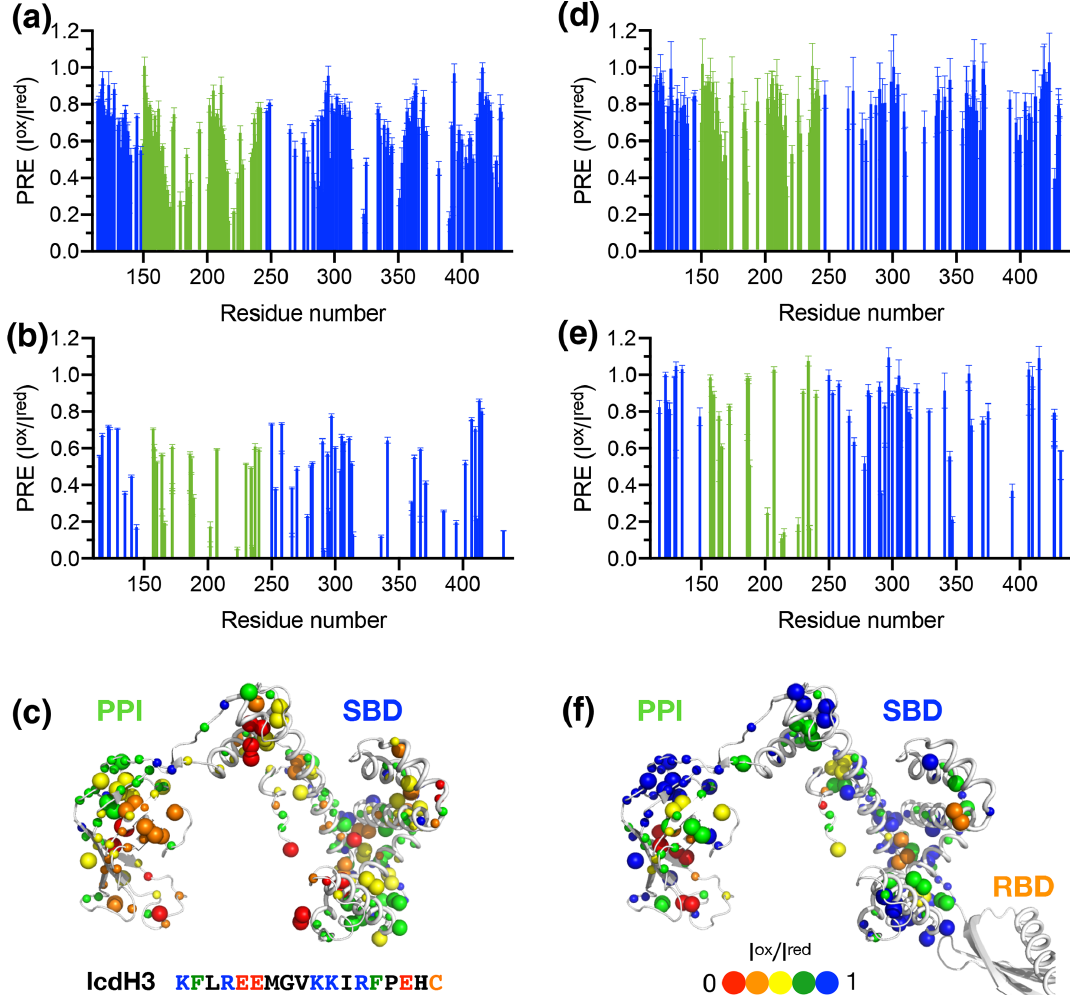
Figure 5. Structural mapping of the PREs induced by MTSL-labeled IcdH2 peptide on TF without and with the RBD. The backbone amide- based PREs of PPI + SBD (a) and full-length TF (d) . The side-chain methyl-based PREs of PPI + SBD (b) and full-length TF (e) . Structural mapping of the observed PREs onto the structure of PPI + SBD (c) and full-length TF (f) . Structural mapping of the PRE of MTSL-labeled IcdH3 peptide on TF variants. The color scheme of the bar charts and the cartoon representations of the structural models are the same as those of Fig.